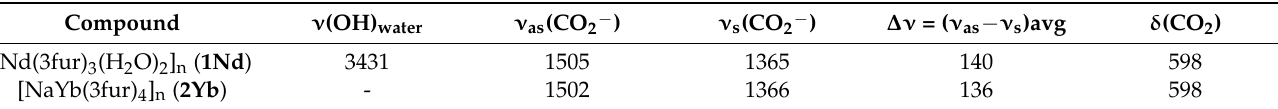
Table 1. Selected infrared bands (cm − 1 ) of the RE III 3-furoate complexes.